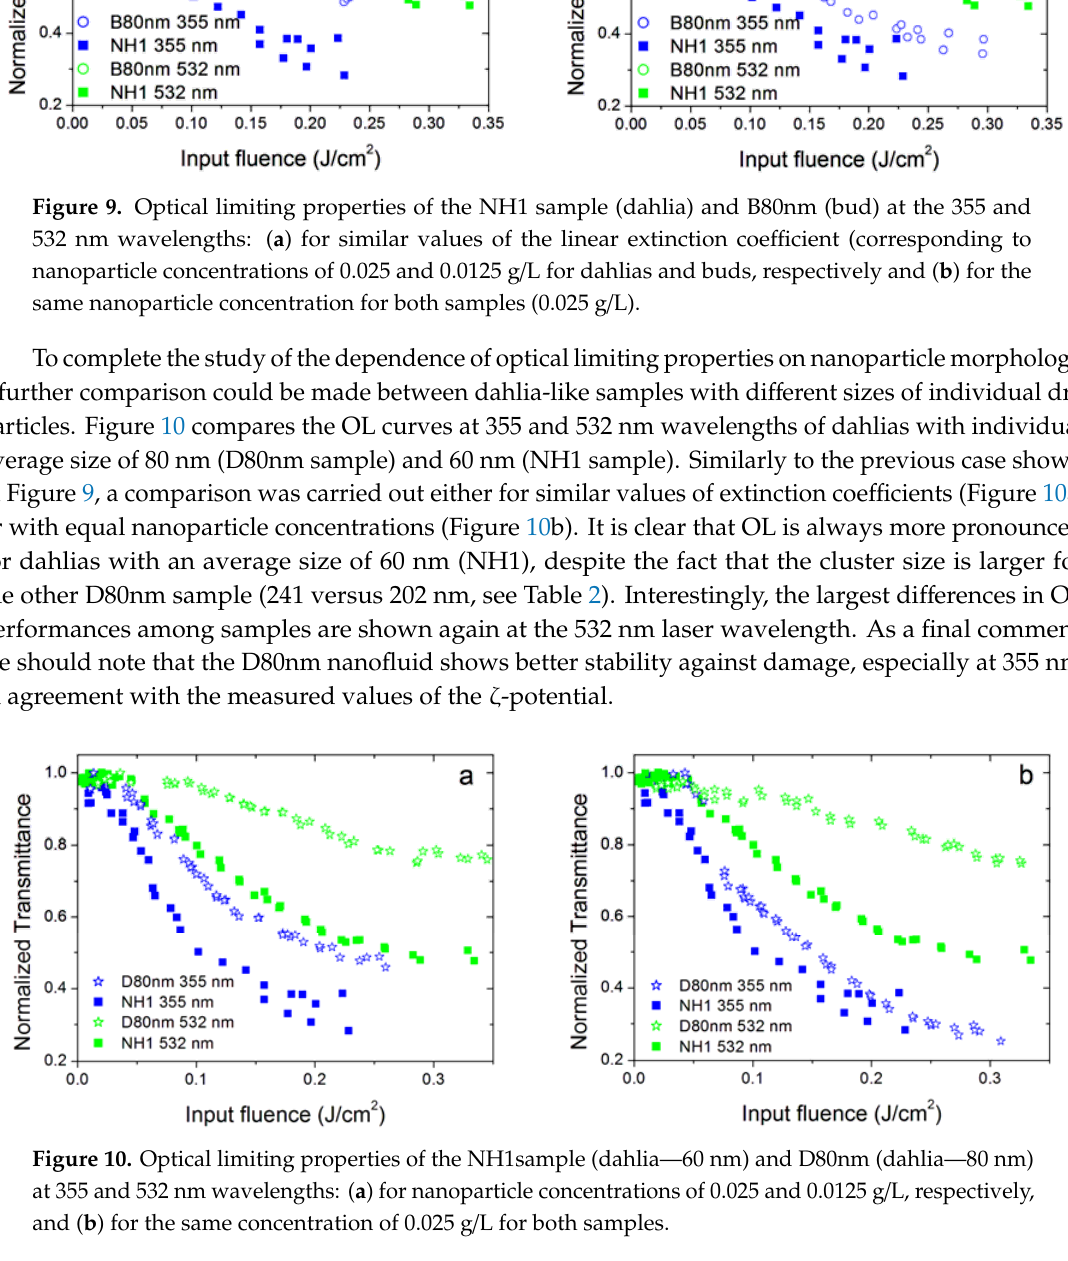
Figure 8. Optical limiting properties of the sample D80nm (dahlia—80 nm) and B80nm (bud—80nm) at 355 and 532 nm wavelengths, for nanoparticle concentration of 0.0125 ( a ) and 0.025 g/L ( b ).